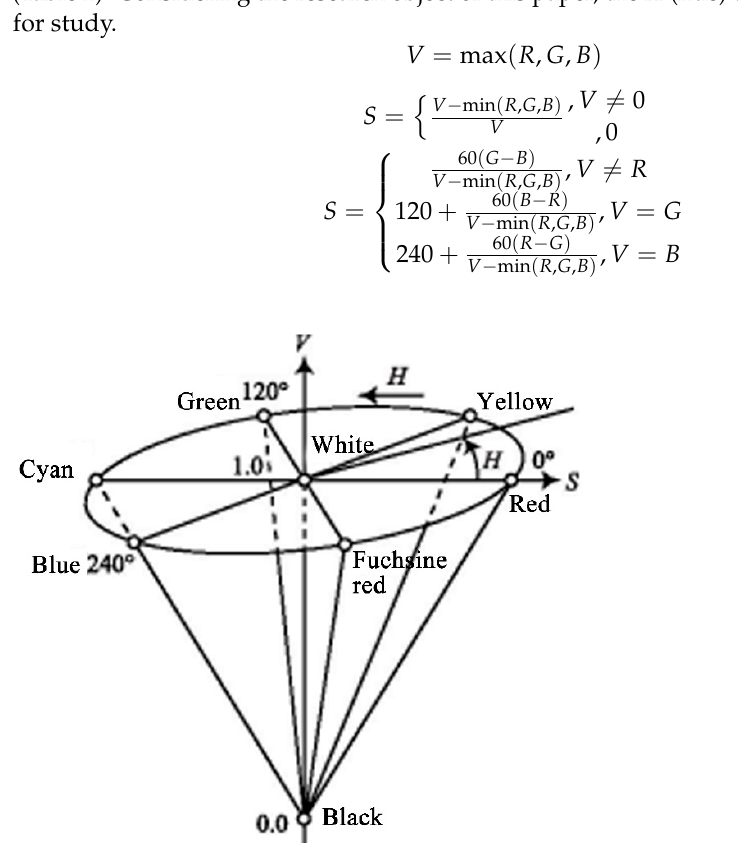
Figure 2. HSV colour space coordinate system.